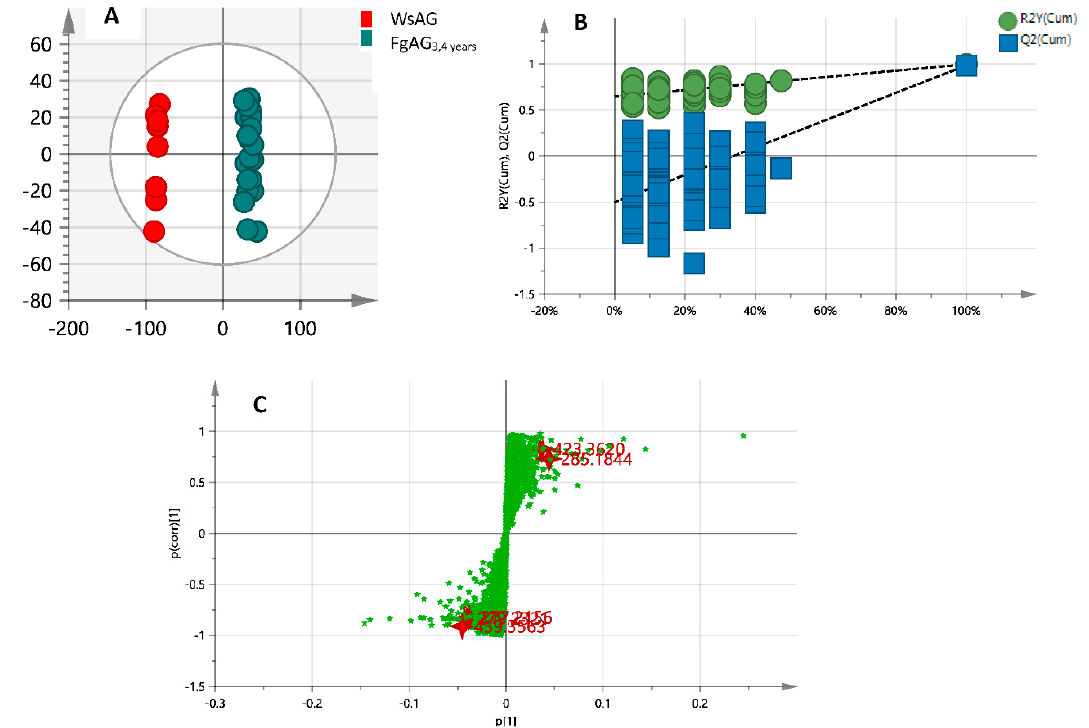
Figure 5. The OPLS-DA ( A ); permutation tests ( B ) and S-plot ( C ) in positive mode.